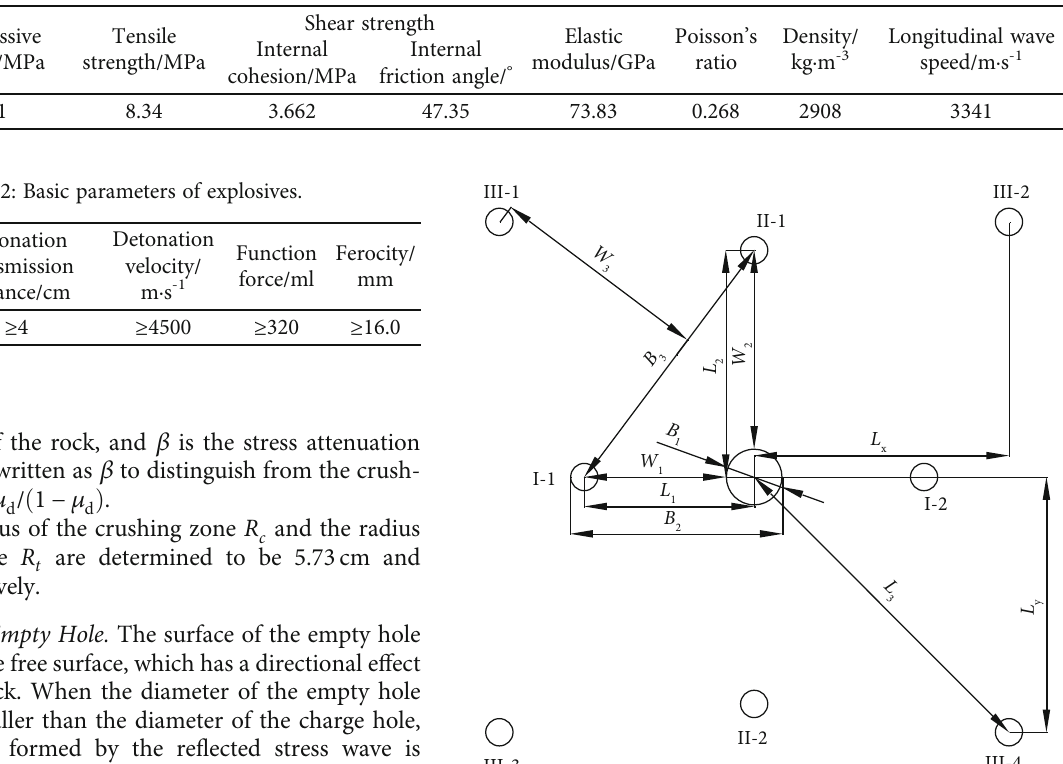
Figure 1: Schematic diagram of the layout position of the vertical cut of the empty